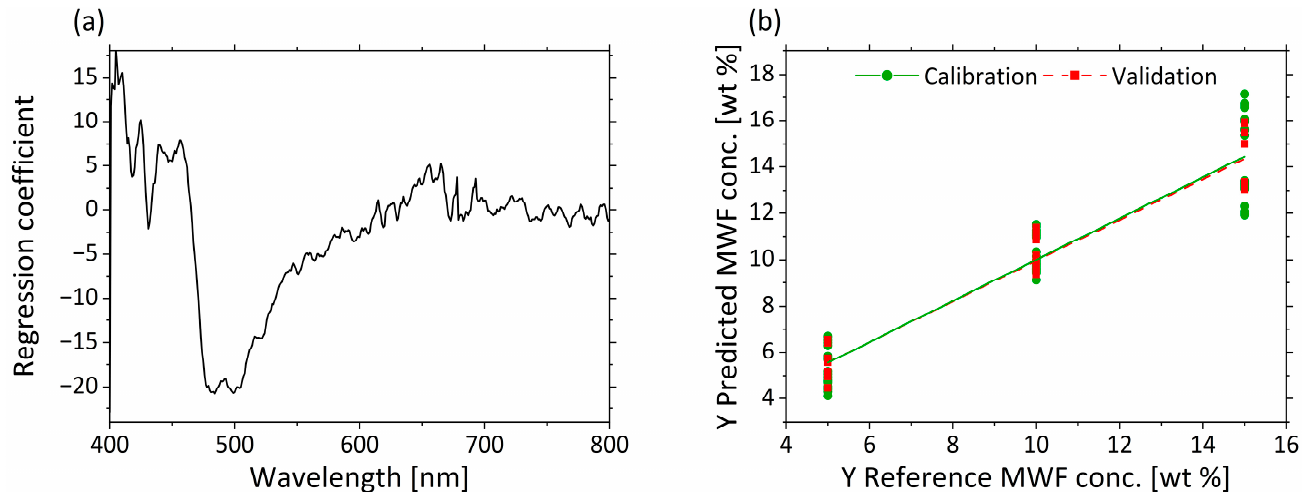
Figure 7. PLS-R with three factors for MWF concentration based on µ a -spectra. The regression coefficients of the three-factor model are shown in ( a ). Predicted vs. reference of MWF concentration for calibration (green) and validation (red) are displayed in ( b ).